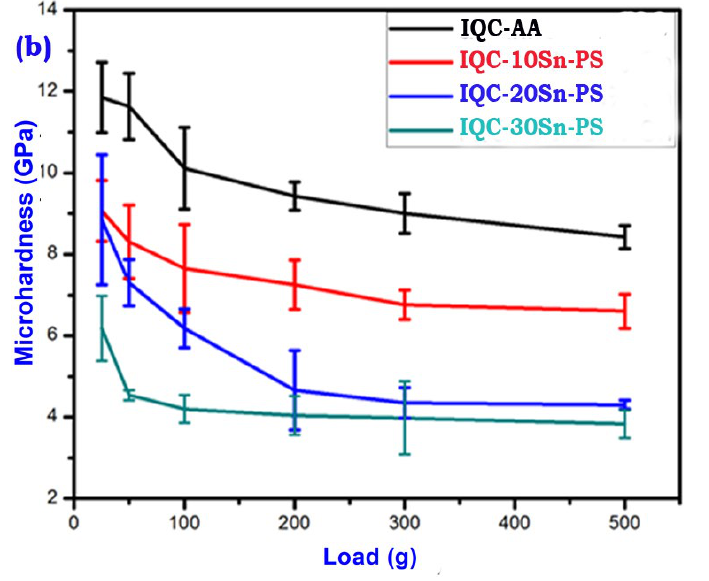
Figure 8. Microhardness value of ( a ) hot-pressed (IQC-10Sn-HP and IQC-10Sn-HPA) and ( b ) pressureless-sintered IQC-Sn bulk composite (IQC-10Sn-PS, IQC-20Sn-PS and IQC-30Sn-PS) at different indentation loads.